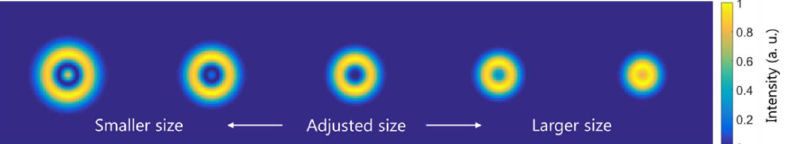
Figure 4. Simulated transversal intensity distributions at the L 2 back focal plane when the CGH is illuminated with the LP 01 mode and the LP 02 mode is implemented in the SLM for different magnification values of the CGH.